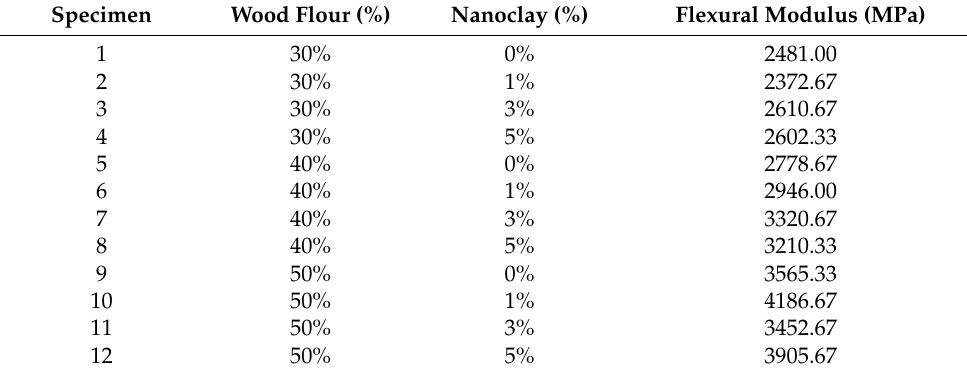
Table 8. The flexural modulus according to the amount of